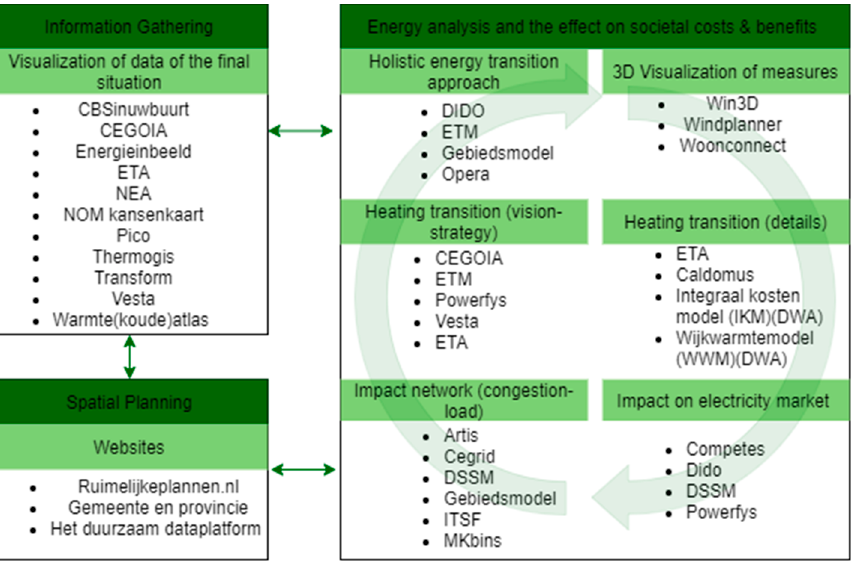
Figure 1. Overview of Dutch energy models used for decision-making support in the heating transition. Image translated and adapted from [45].